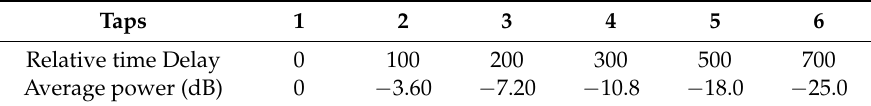
Table 1. Indoor model of ITU-R M.1225 Channel